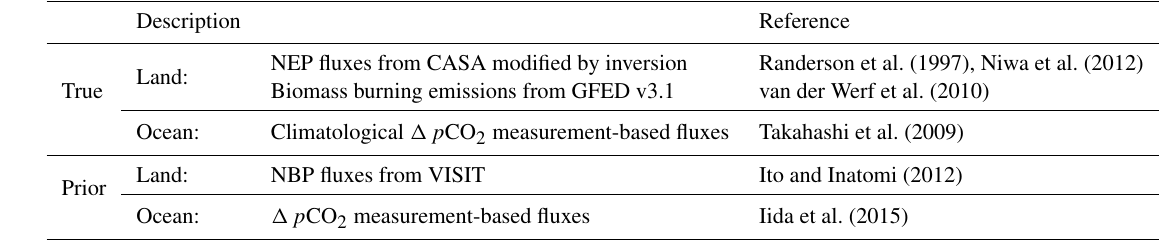
Table 1. Prior and true flux datasets (other than the fossil fuel emission) used in the identical twin experiment.